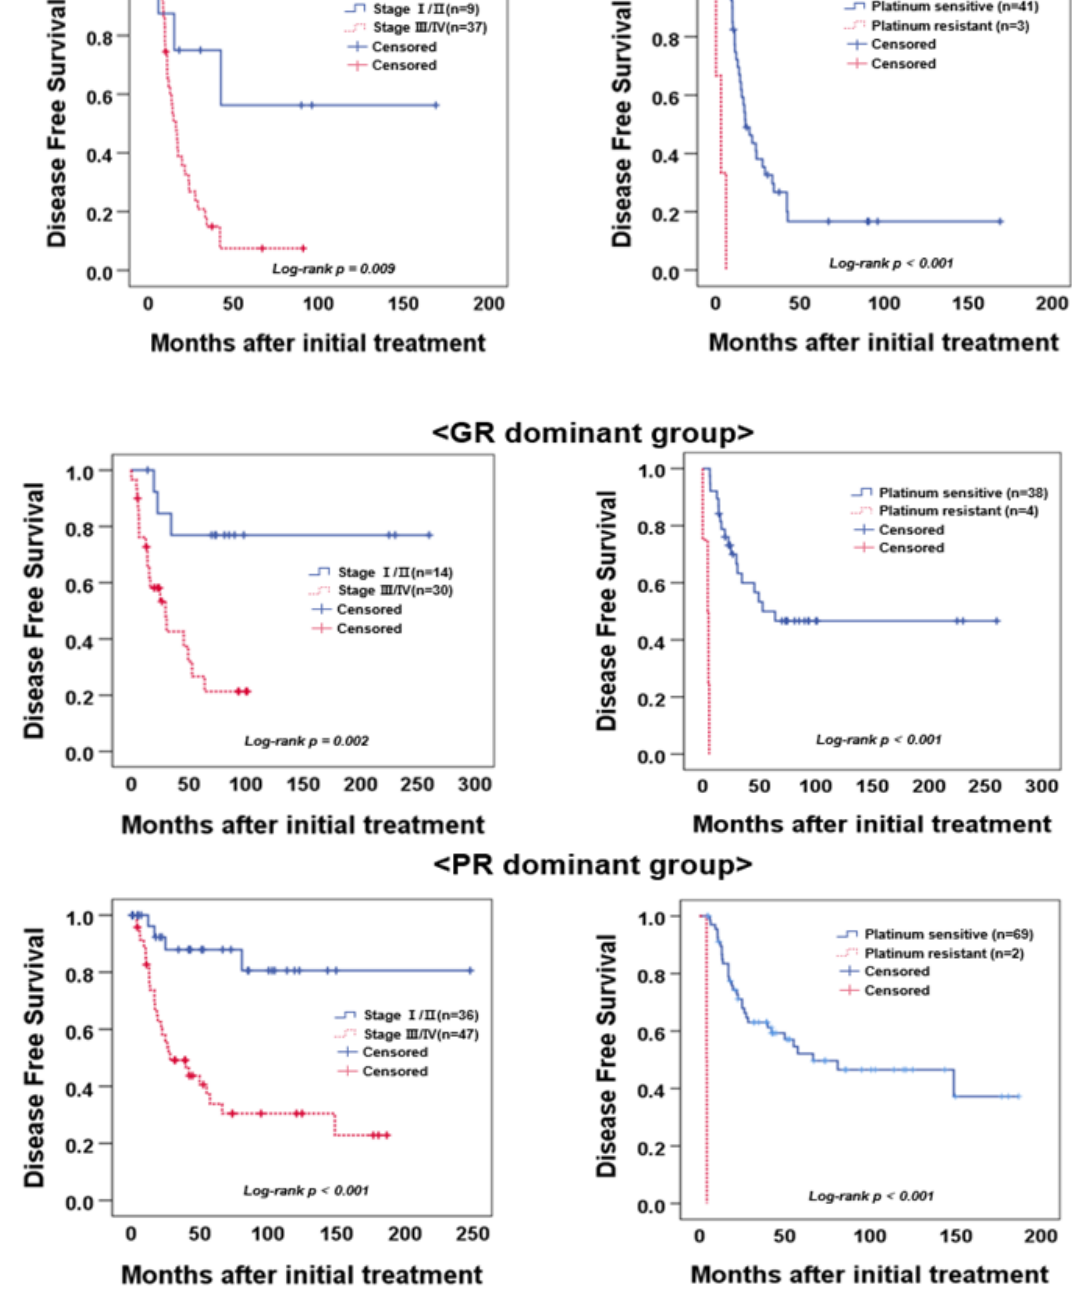
Figure 2. Hierarchical clustering analysis of hormone receptor expression in EOCs. ( A ) Hierarchical clustering analysis of all patient samples in which staining for all five receptors was performed. On the left, the three subgroups identified using the clustering analysis are indicated. Vertically, the expression of different receptors is depicted: orange indicating positive expression and purple indicating negative expression. Color scaling was based on the semi-quantitative immunoscores. ( B ) DFS and OS of patients with EOC between the triple dominant group and GR- or PR-dominant group. Forty-eight patients with EOC in the triple dominant group and 148 patients with EOC in the GR- or PR-dominant group were included. ( C ) Subgroup DFS analysis in the triple dominant group was based on the FIGO stage and platinum sensitivity (n = 196). Table 1. Univariate and multivariate analyses of the association between prognostic variables and disease-free survival rates in epithelial ovarian cancer. Variables